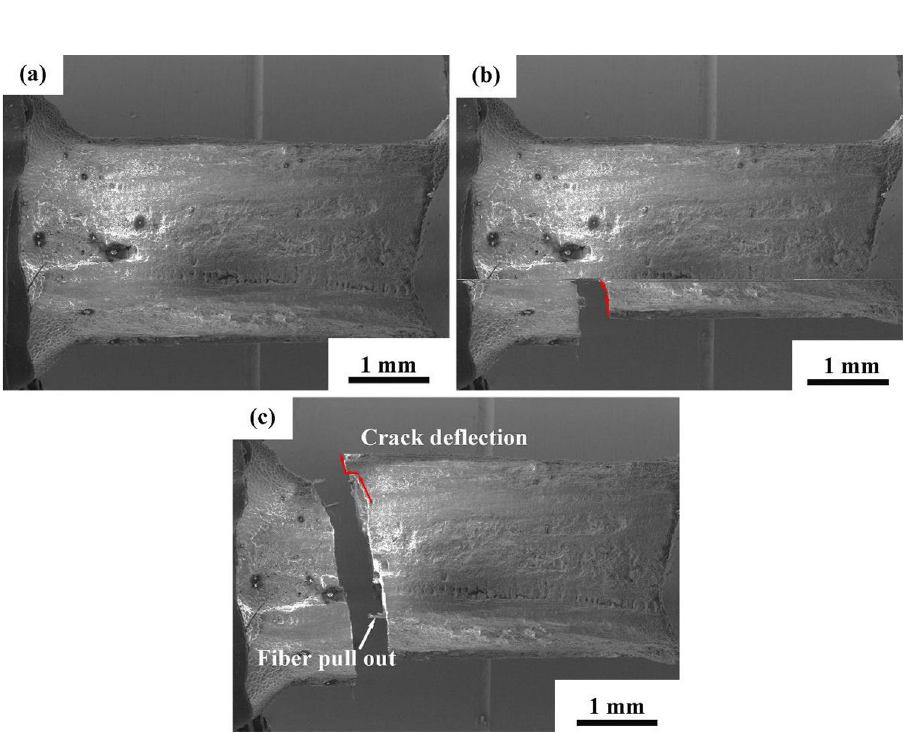
Figure 12. In-situ tensile SEM observation of SiC f /CaWO 4 /SiC minicomposite oxidized at 1100 ℃ for 50